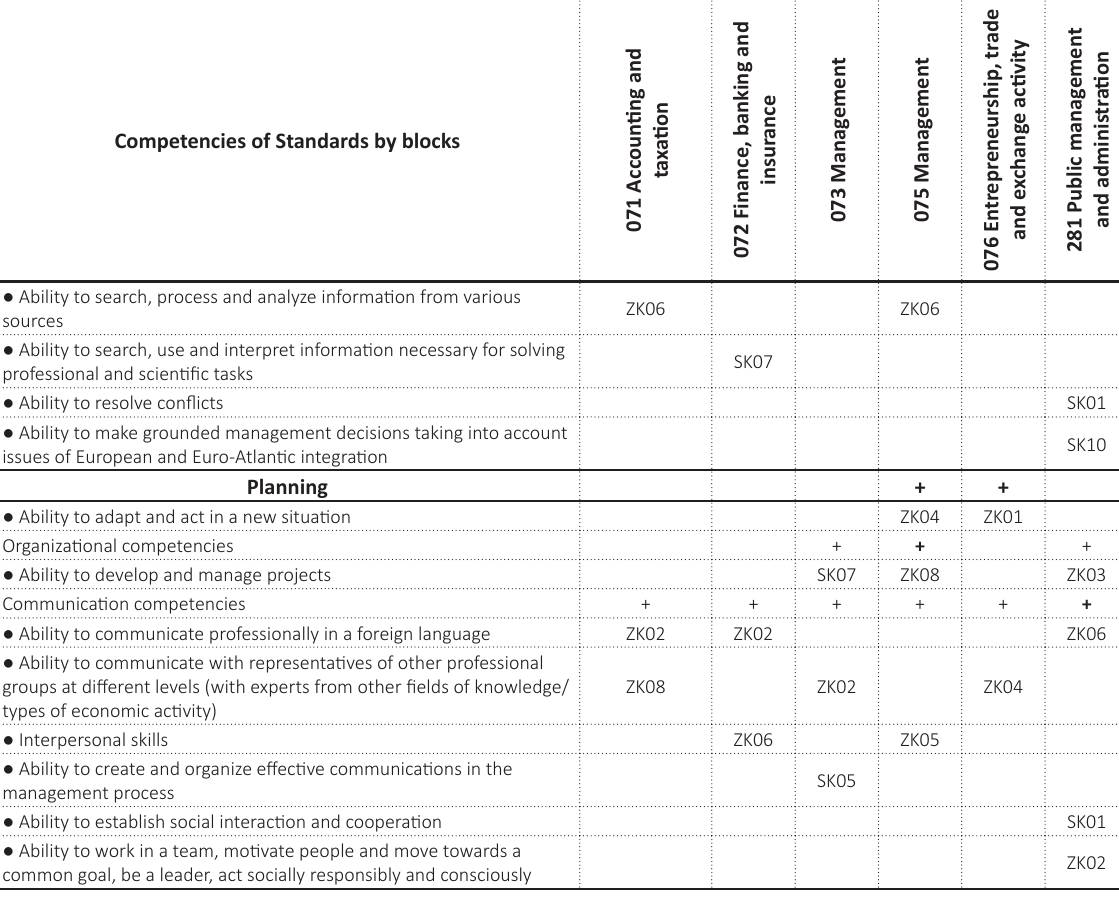
Table A2 (cont.). Analysis of managerial competencies available in Standards by fields of knowledge 07 “Management and administration” and 28 “Public management and